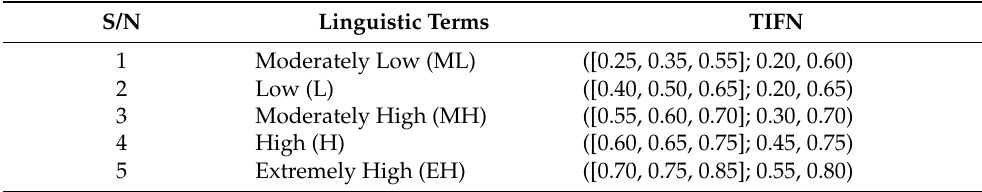
Table 2. The linguistic scale and its TIFN equivalent used for data collection.